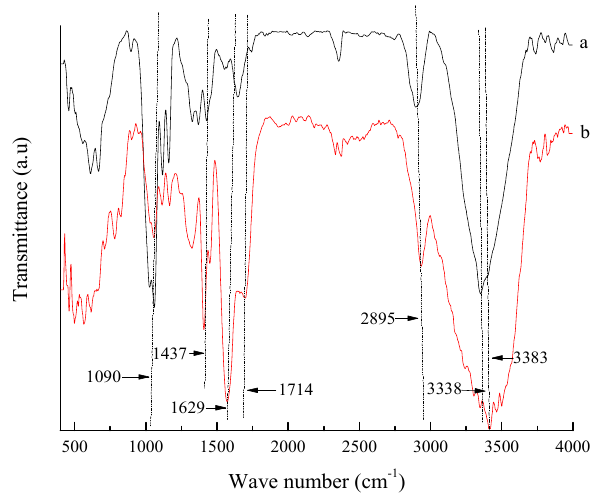
Figure 9. FT-IR spectra of the BC sample and composite: ( a ) BC original sample; ( b ) composite.